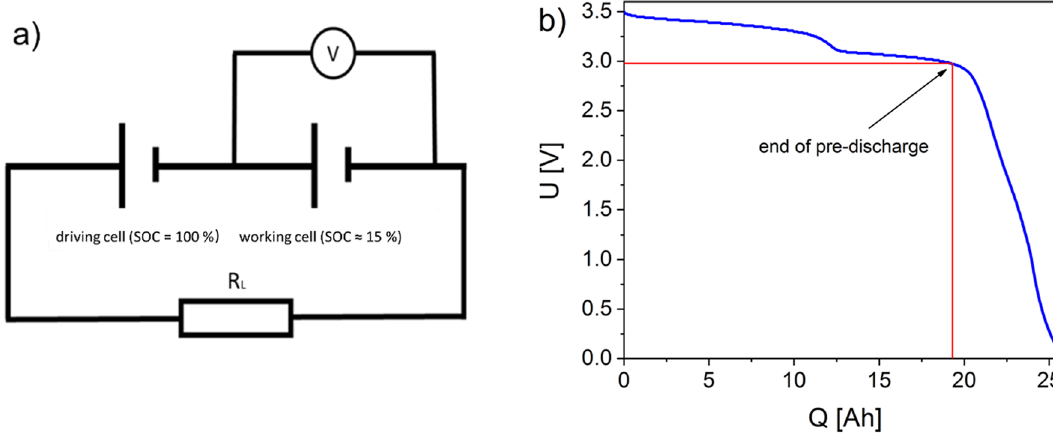
Figure 2. ( a ) Schematic layout of the series connection (SOC Cell 2 < < SOC Cell 1), ( b ) discharge curve of a single cell at 41 mΩ, red marking, point at which the pre-discharge was stopped for the experiments with a series connection.